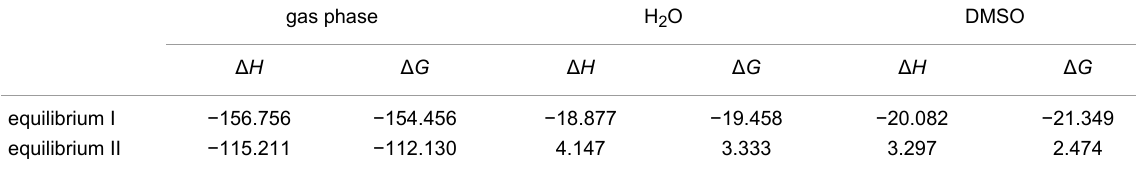
Table 2: Main thermodynamic data obtained from the acid–base equilibria considered (kcal·mol − 1